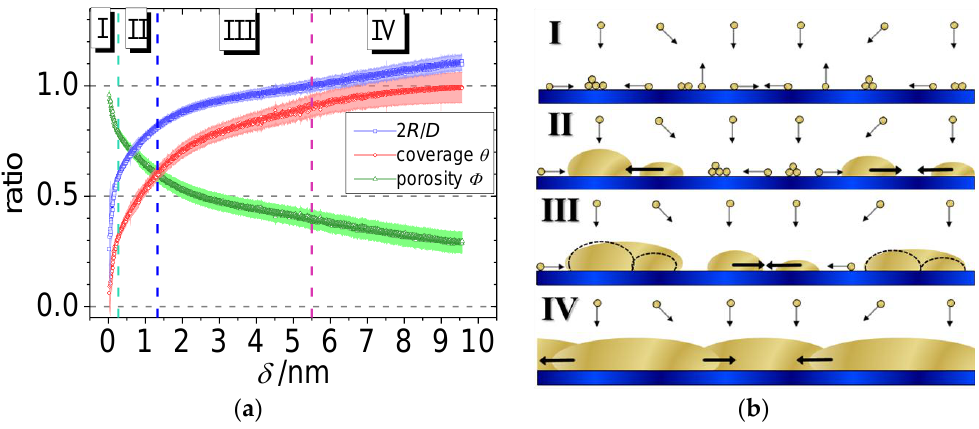
Figure 4. Au sputter deposition on amorphous silicon oxide: ( a ) Evolution of aspect ratio 2 R/D (blue symbols, R = radius, D = center-to-center distance of the Au clusters), coverage θ (red symbols) and porosity Φ (green symbols) as a function of effective thickness δ ≈ 0.0032 nm/frame of Au on SiO x . ( b ) Schematic side view of the four gold cluster growth regimes with the predominant processes: Nucleation (I), diffusion-mediated coalescence (II) ( D > 2R ), and adsorption-mediated cluster growth (III) until the percolation threshold ( D = 2R ). Afterwards, movement of grain boundaries leads to a permanent growth of a dominant cluster at the expense of the adjacent clusters (IV). Adapted from reference [133] with permission from the Royal Society of Chemistry, 2013.